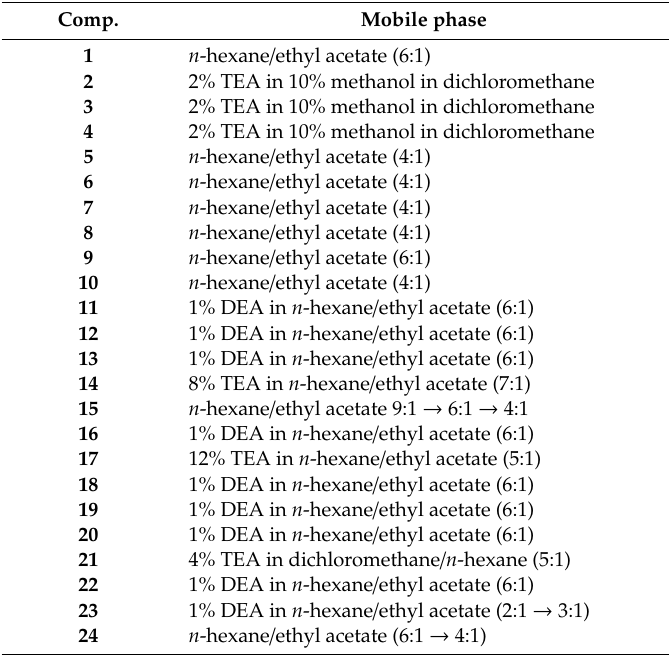
Table 2. Mobile phases used for purification of the compounds 1–24